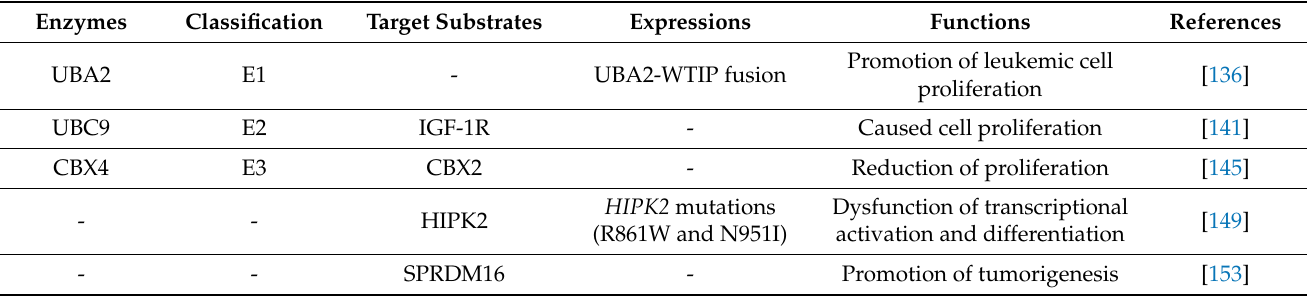
Table 5. SUMOylation-related enzymes and substrates, and their expressions and functions in